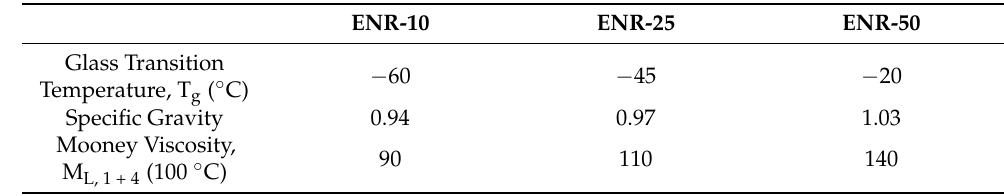
Figure 5. Epoxidized Natural Rubber (ENR) molecular structure. Reproduced from [155], IOP Publishing Ltd, 2018. Table 3. ENR properties depend on grade.